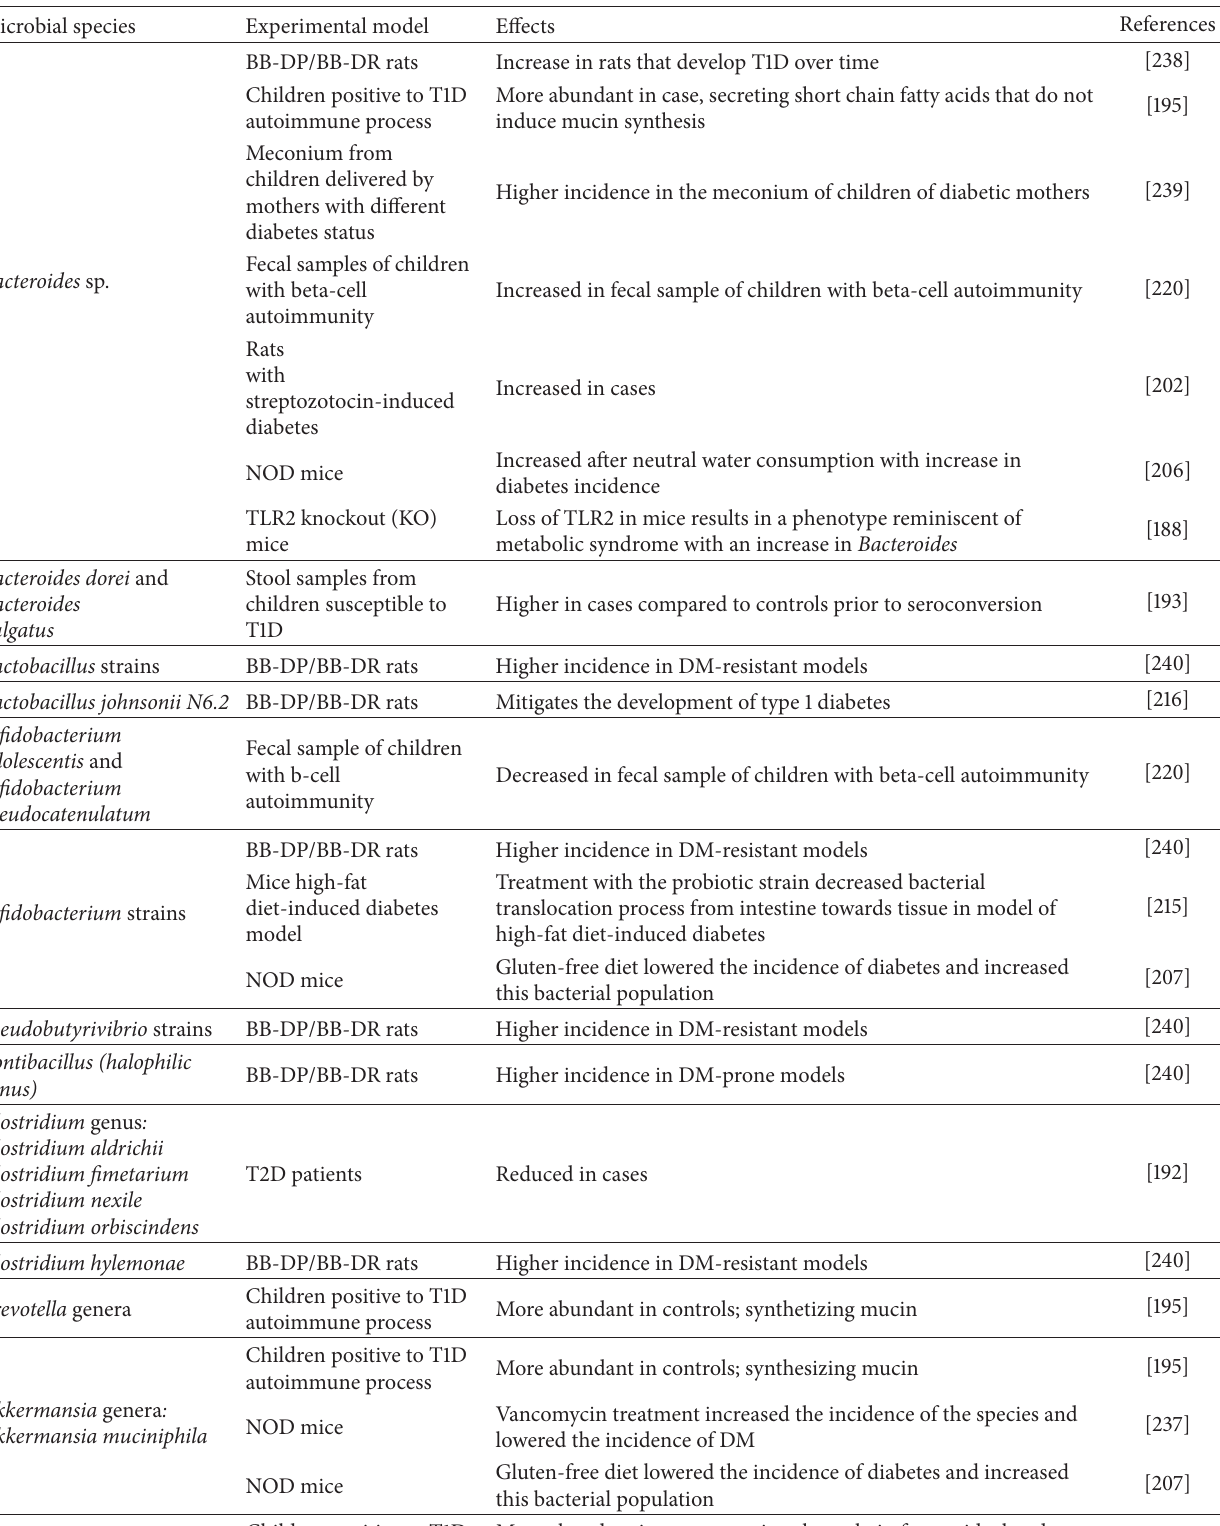
Table 1: Microbial species implicated in diabetes. A current list of the characterized microbes is shown, which includes the experimental models that were evaluated and the observed effects according to each microbial species. The respective bibliographies are also listed (last